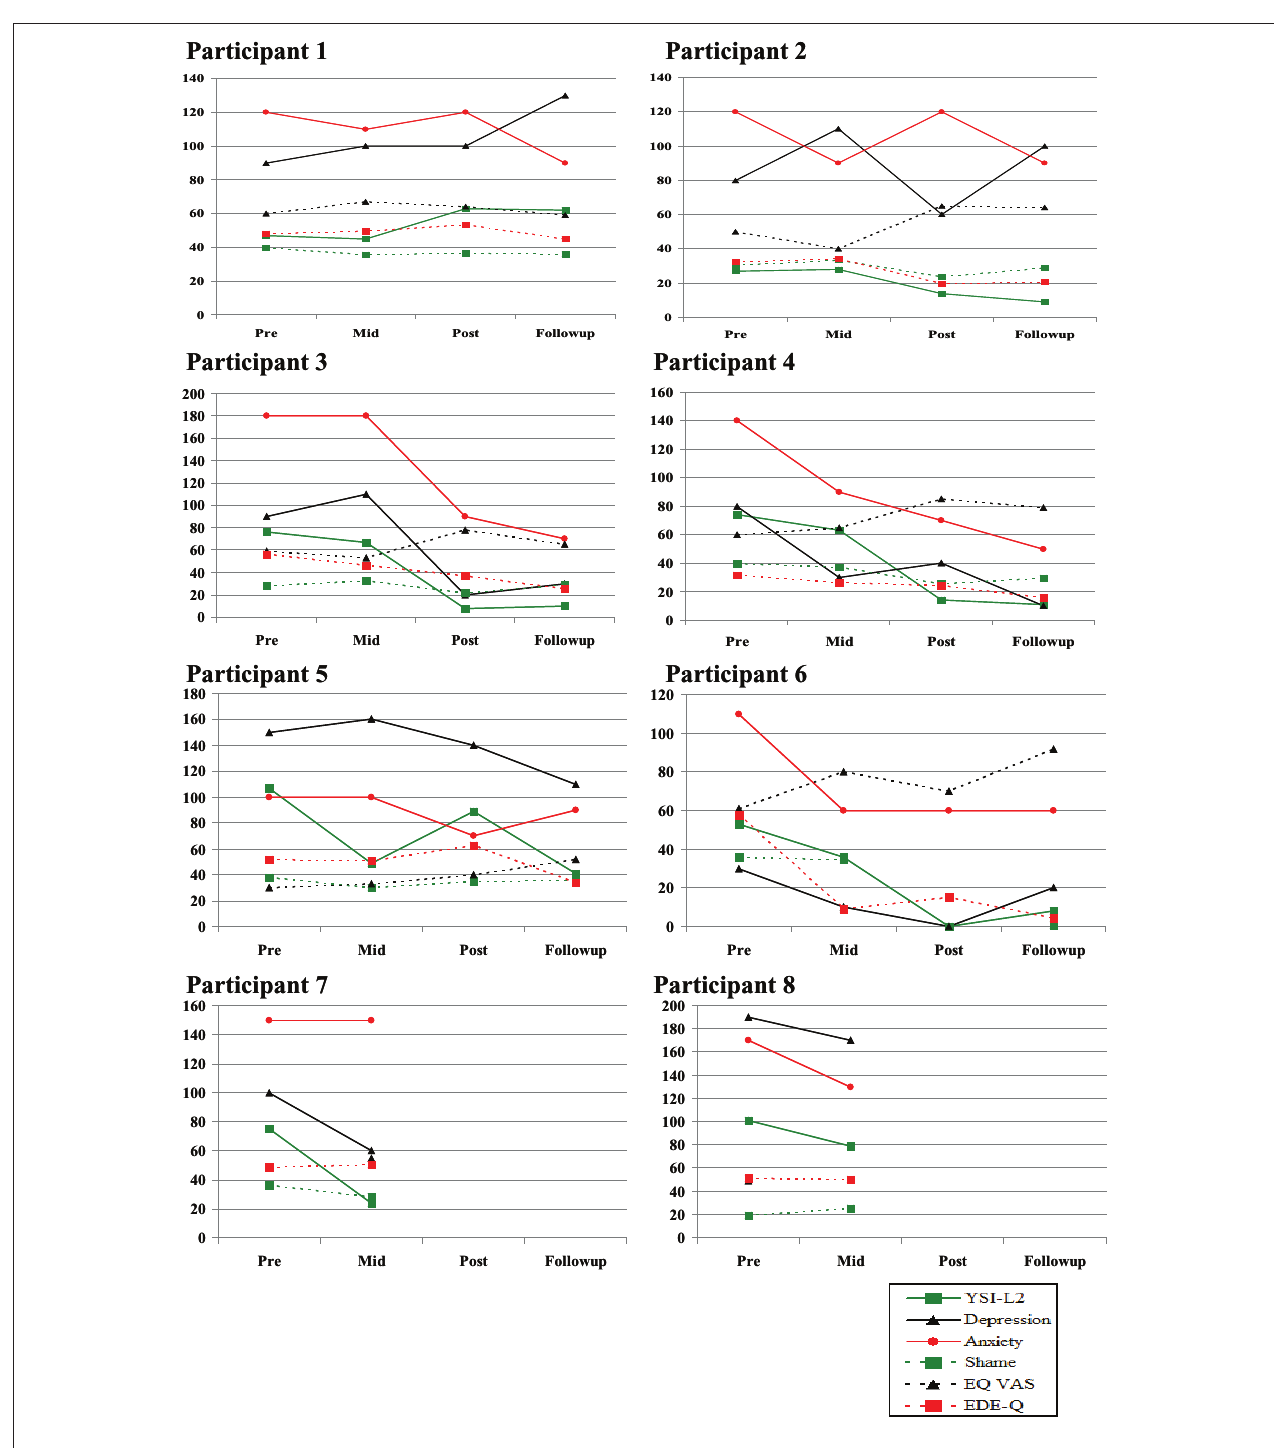
FIgurE 2 | global scores on YSI-L2, Depression (HADS), Anxiety (HADS), Shame, EQ VAS, EDE-Q from pre-treatment through mid-, post-, and